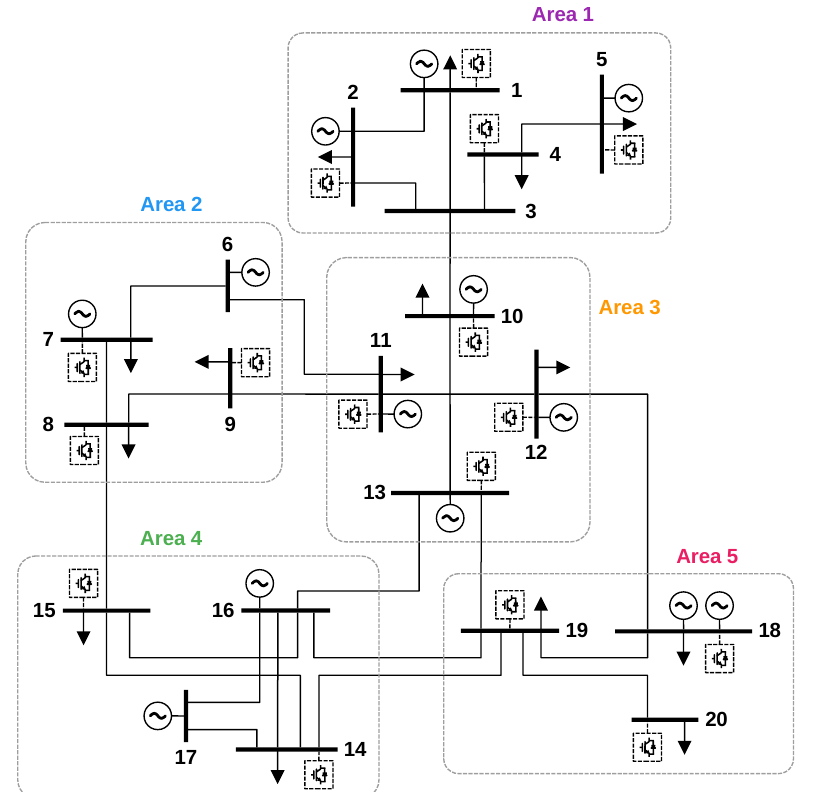
Figure 14. Simplified representation of the interconnected national system of